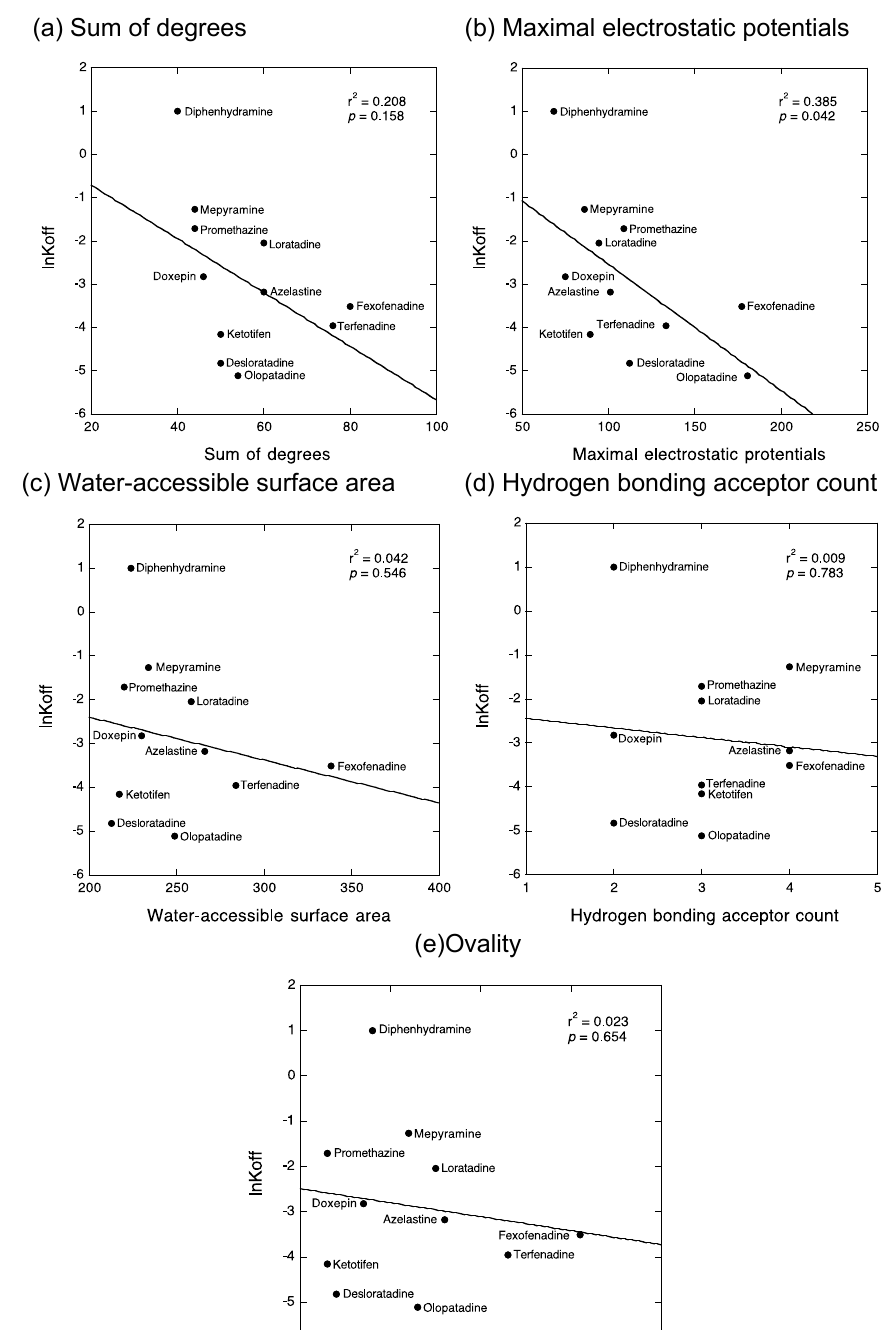
Figure 4. Relationship between the k off values of antihistamines and their physicochemical properties involved in thermodynamic binding parameters. Relationship of the values of ln k off with sum of degree ( a ), maximal electrostatic potentials ( b ), water-accessible surface area ( c ), hydrogen bonding acceptor count ( d ), and ovality ( e ). A significant relationship was observed only between the values of ln k off and maximal electrostatic potentials ( b ). k off : rate constant of dissociation.